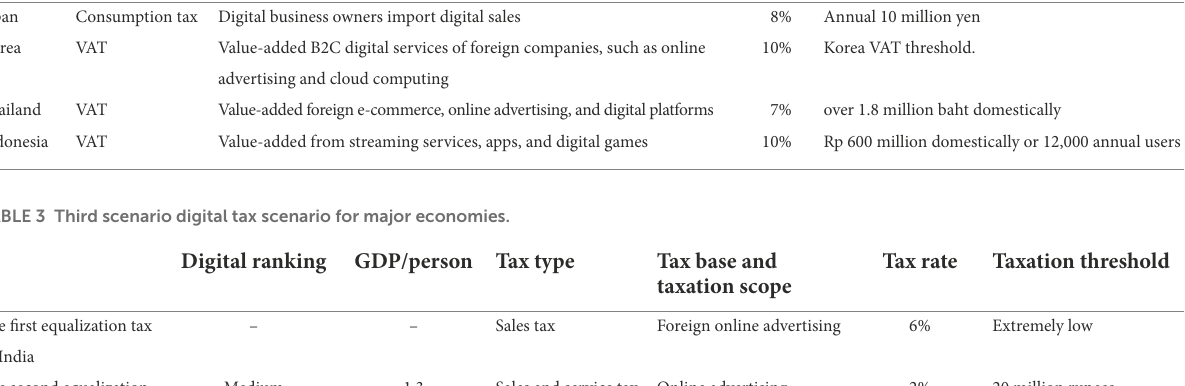
TABLE 2 Digital taxation scheme for major economies in the second scenario.